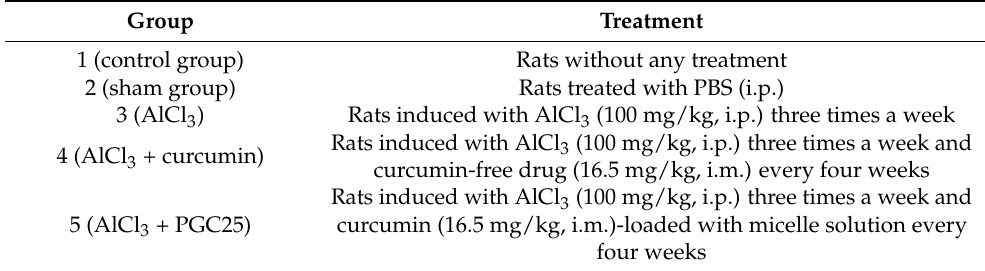
Table 1. The groups of animals used in animal study. Group